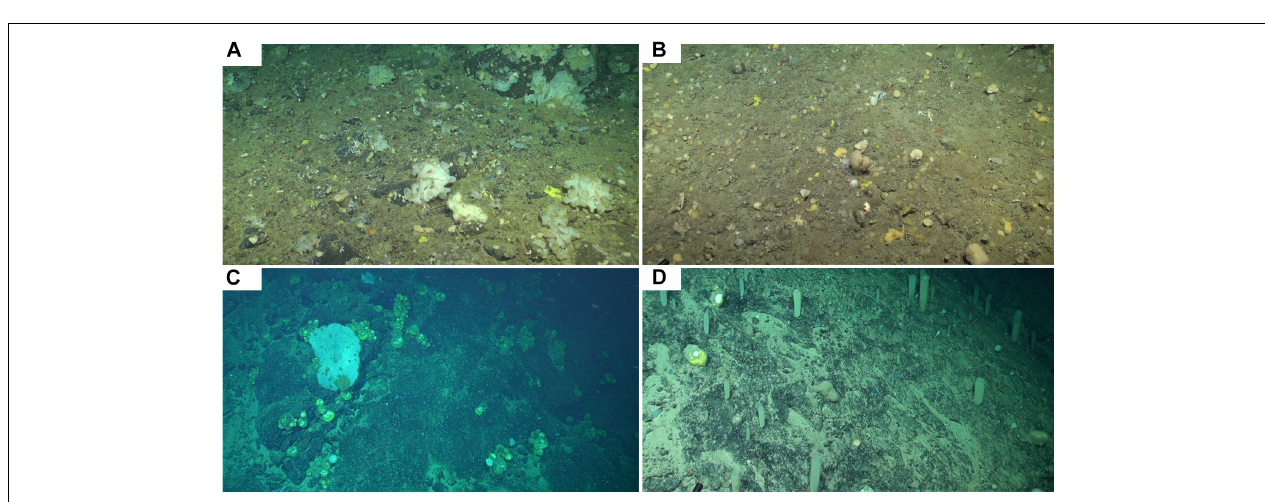
FIGURE 2 | ROV Image of the four study areas from the DY081 Cruise (A) Nuuk, (B) SWGL, (C) GOK, and (D) HOK. Red laser scale makers are 10 cm apart.